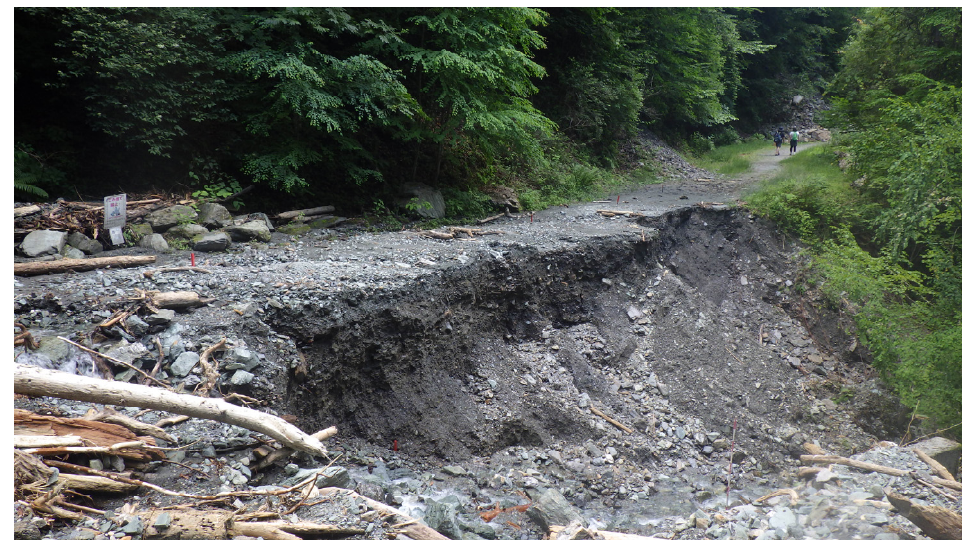
Figure 1. Image of forest road failure. A culvert at a stream crossing was destroyed by heavy rain, and the road body was eroded by stream water, making it inaccessible to vehicles.